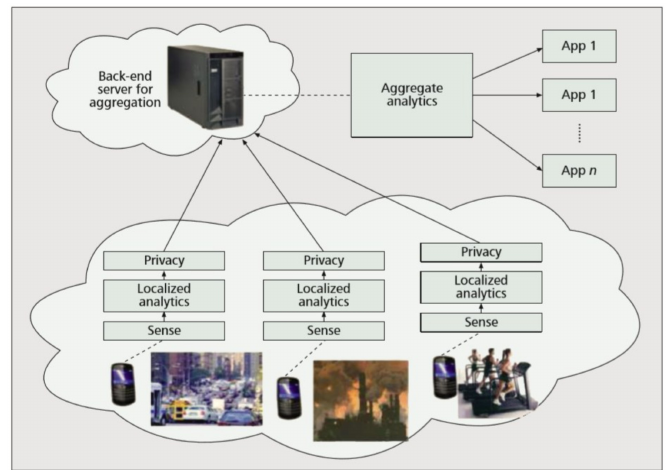
Figure 1. Typical functioning of mobile crowd sensing (MCS)